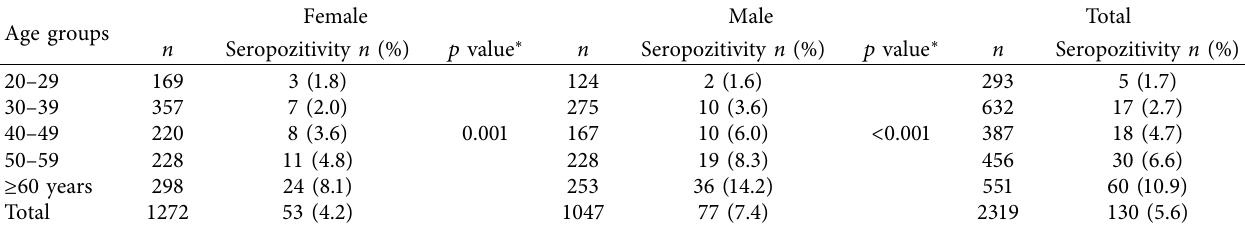
Table 3: Comparison of anti-CCHF IgG seropositivity frequency in females and males by age groups of the participants.